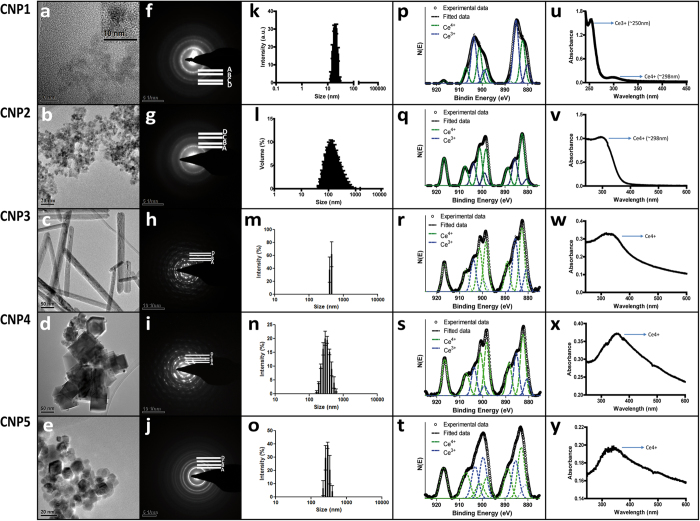
Characterization of synthesized CNPs.(a–e) photographs show TEM images of the five CNPs (inset on CNP1: high magnification image). (f–j) Show selected areas of electron diffraction pattern of CNPs (different crystal planes of fluorite crystal structure). (k–o) Graphs represent the nanoparticle hydrodynamic radius. (p–t) Images show deconvoluted XPS spectra of all CNPs. The UV−vis absorption spectra of CNPs suspension is represented in (u–y).